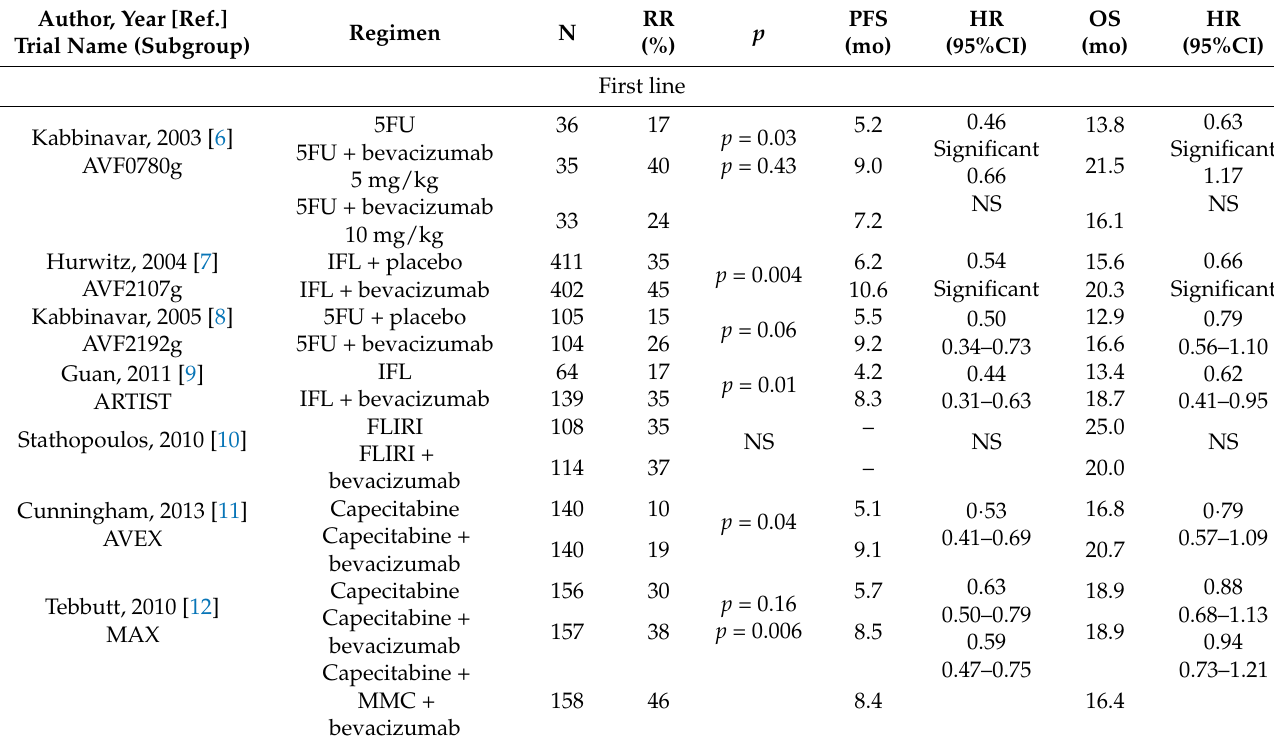
Table 1. Principal trials comparing first line combination chemotherapy with or without bevacizumab in unselected patients with metastatic colorectal cancer